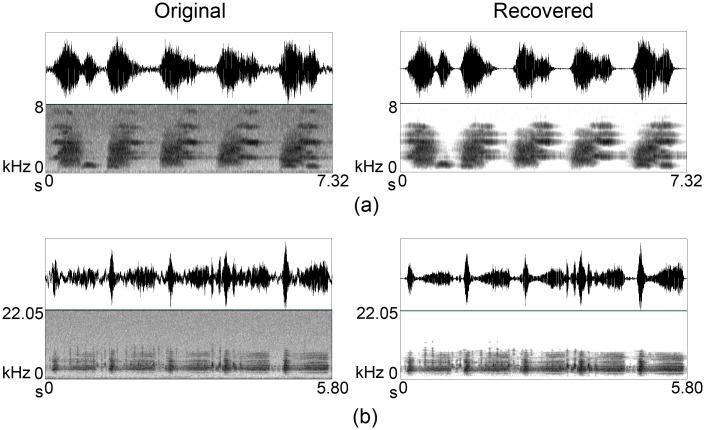
Denoising overlapped songs.Male kiwi, female kiwi, and more-pork are overlapped in (a) and kakapo chinging overlapped with mottled petrels (Pterodroma inexpectata) in (b).